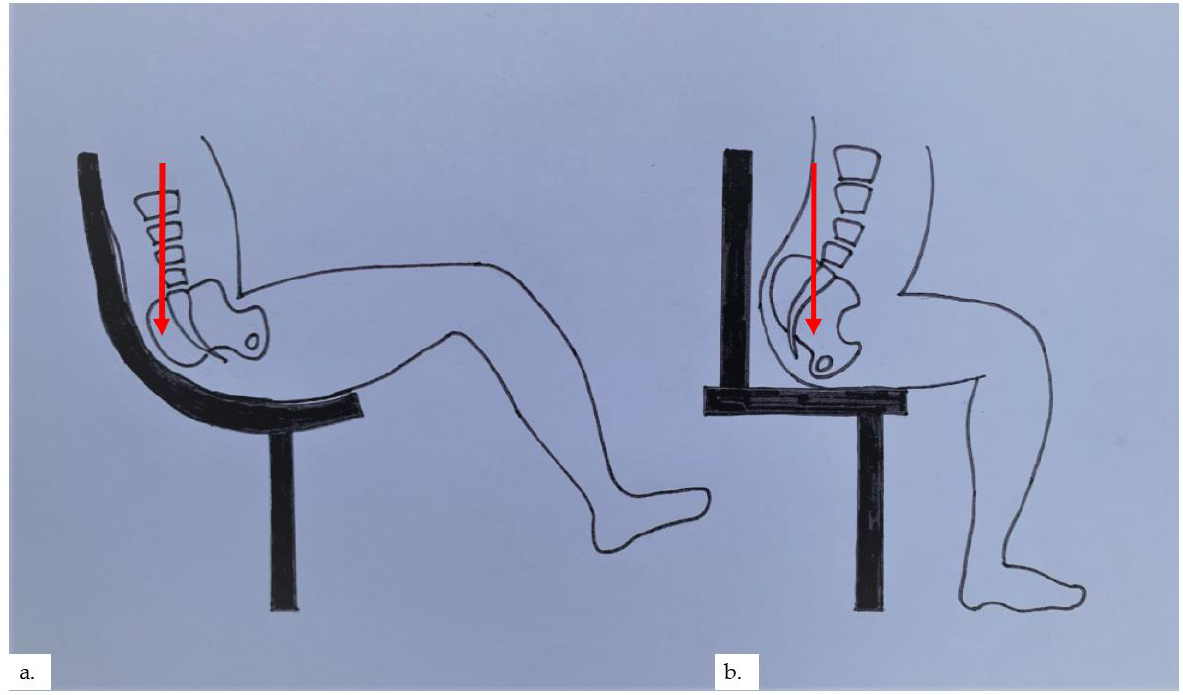
Figure 9. ( a ) Reclined sitting position places pressure on the coccygeal apex; ( b ) upright 90° sitting angle places pressure on the base of the sitter’s triangle. angle places pressure on the base of the sitter’s